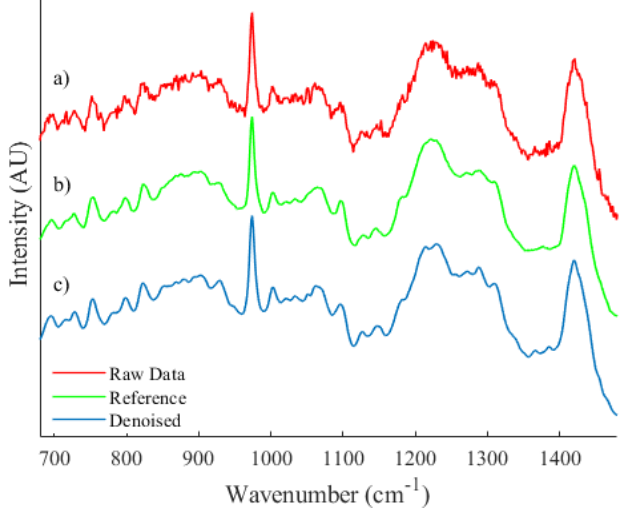
Figure 6. A qualitative comparison between ( a ) an unprocessed spectrum recorded from a biological sample, ( b ) a reference spectrum and ( c ) the resulting denoised